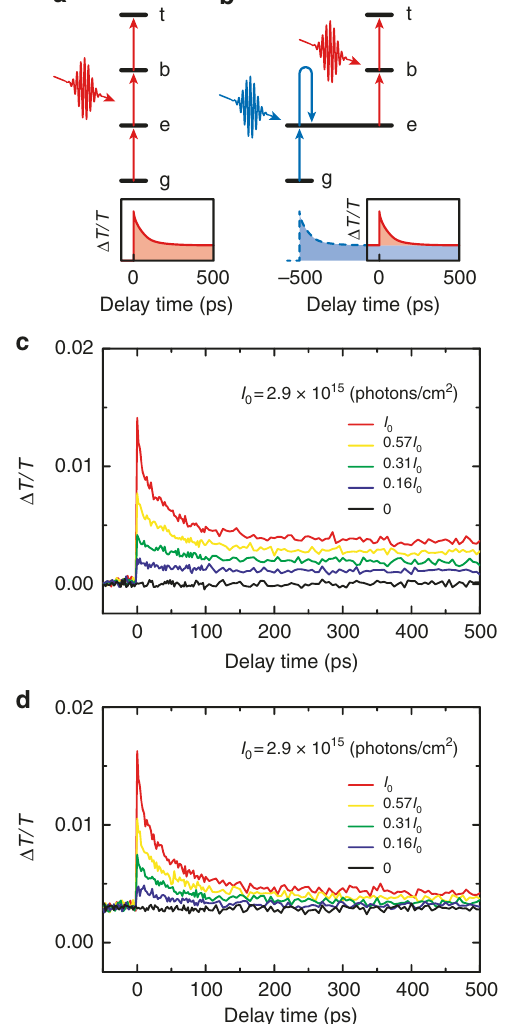
Fig. 2 Excitation diagrams and TA dynamics in single and double pump- pulse measurements. a , b Excitation diagrams for a single and b double pump-pulse experiments. The unoccupied ground state, single exciton, biexciton, and triexciton states are denoted by g, e, b, and t, respectively. c , d Pump- fl uence dependence of the TA dynamics under c single and d double pump-pulse excitation. In the double pulse excitation, the fi rst pump pulse had a constant fl uence of 0.52 I 0 and excited the sample at the delay time of − 500 ps. The photon fl uences of the pump pulse that excites the sample at 0 ps are shown in the fi